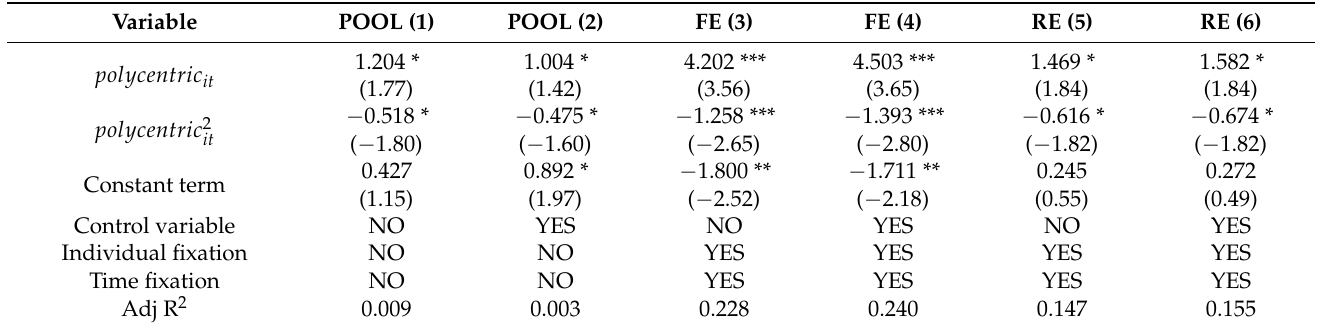
Table 4. Impact of polycentric spatial structure on ULUE (Full sample